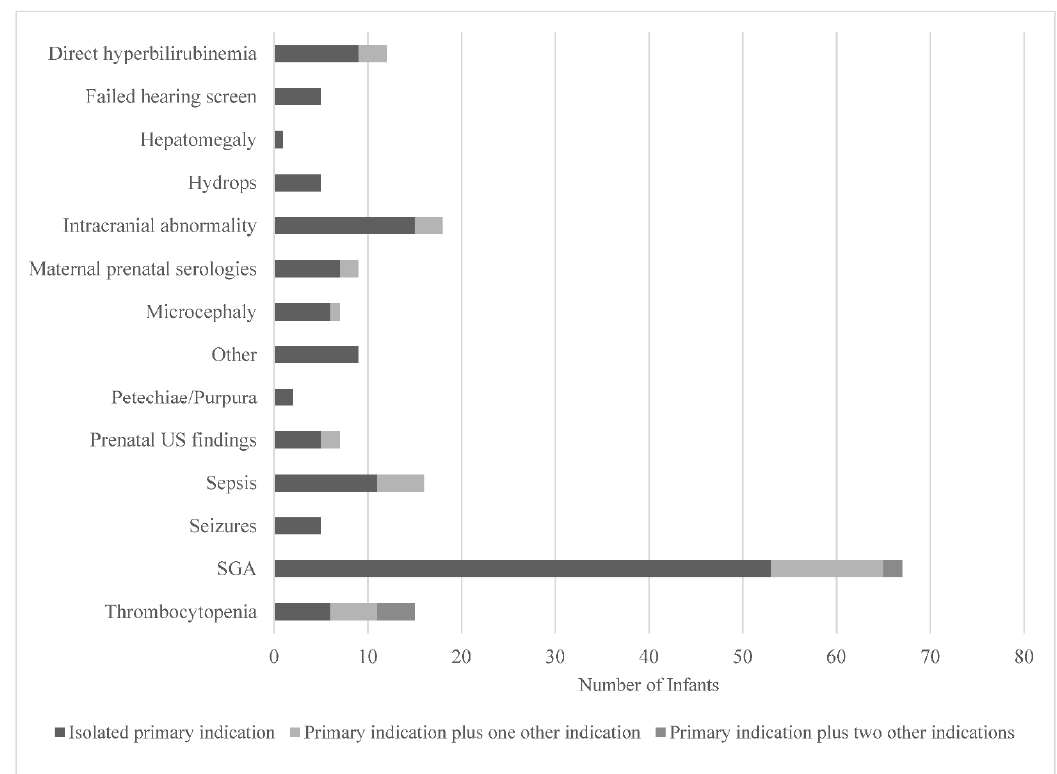
Figure 3. Clinical indications prompting cCMV testing in infants as documented by healthcare pro- viders in a quaternary children’s hospital from 2014 to 2019. Abbreviations: US—ultrasound; SGA— small-for-gestational age. Other includes slow weight gain, intractable diarrhea, cholestasis, liver failure, hemophagocytic lymphohistiocytosis, immunodeficiency, and pre-cardiac transplant eval- uation.